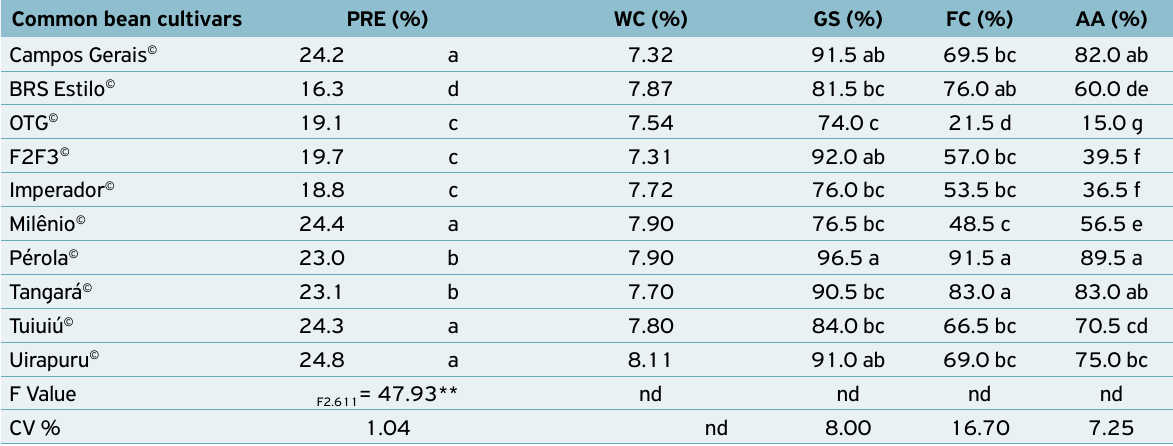
Table 3. Average of primary root emission (“Blotter Test”) (PRE). water content (WC). germination on substrate (“steril sand”) (GS). first count (FC. %) and accelerated aging (AA) of common bean commercial seeds harvested in 2015/2016. Common bean cultivars PRE